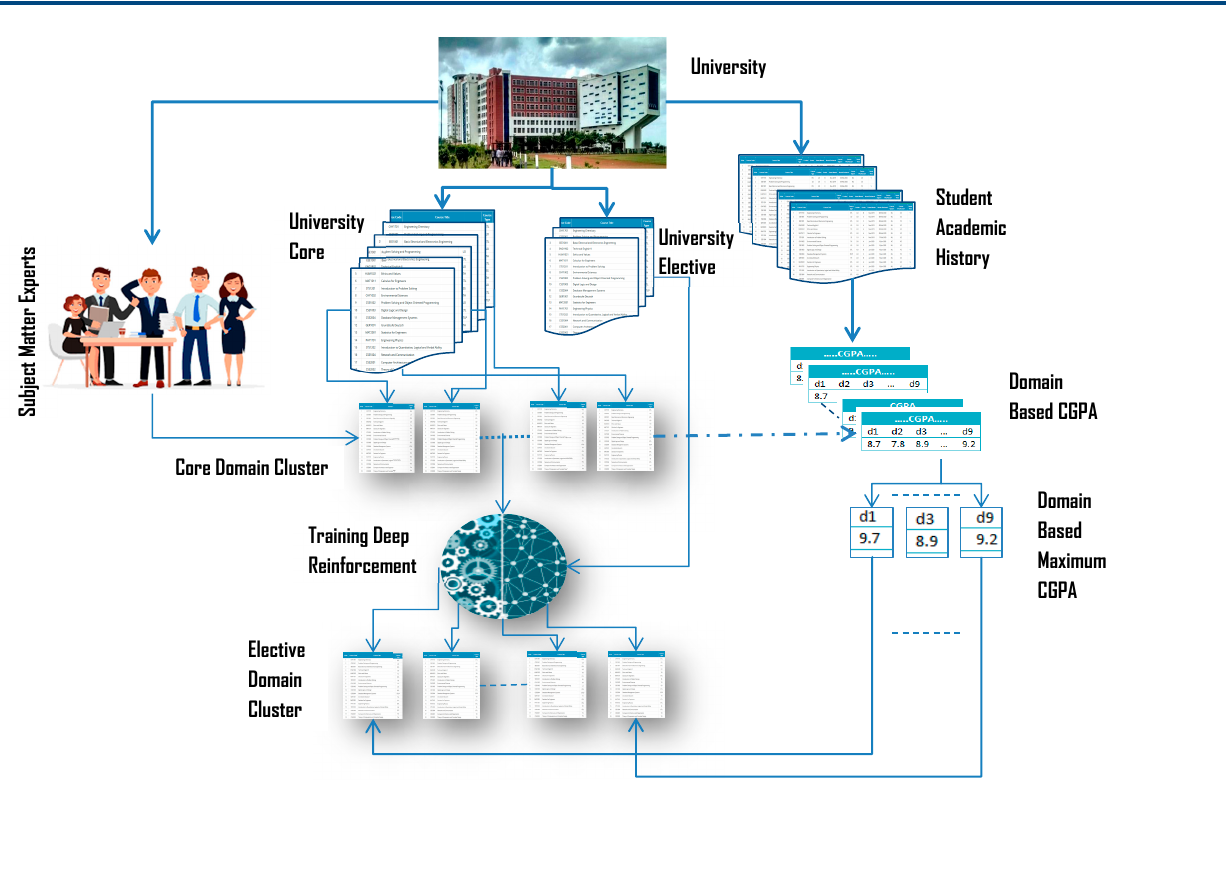
Figure 4. The proposed architecture diagram of the elective course recommendation